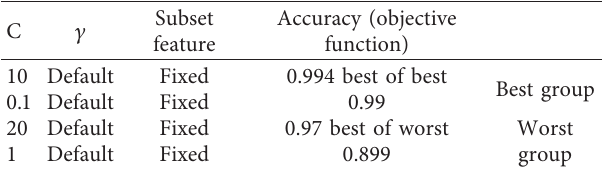
Table 4: Best and Worst groups for C.